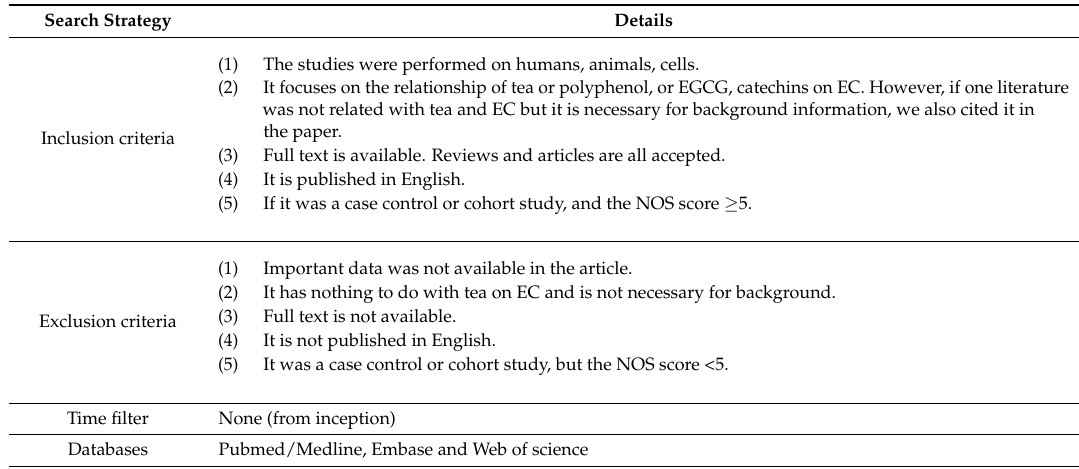
Table 1. Inclusion and exclusion criteria for literature